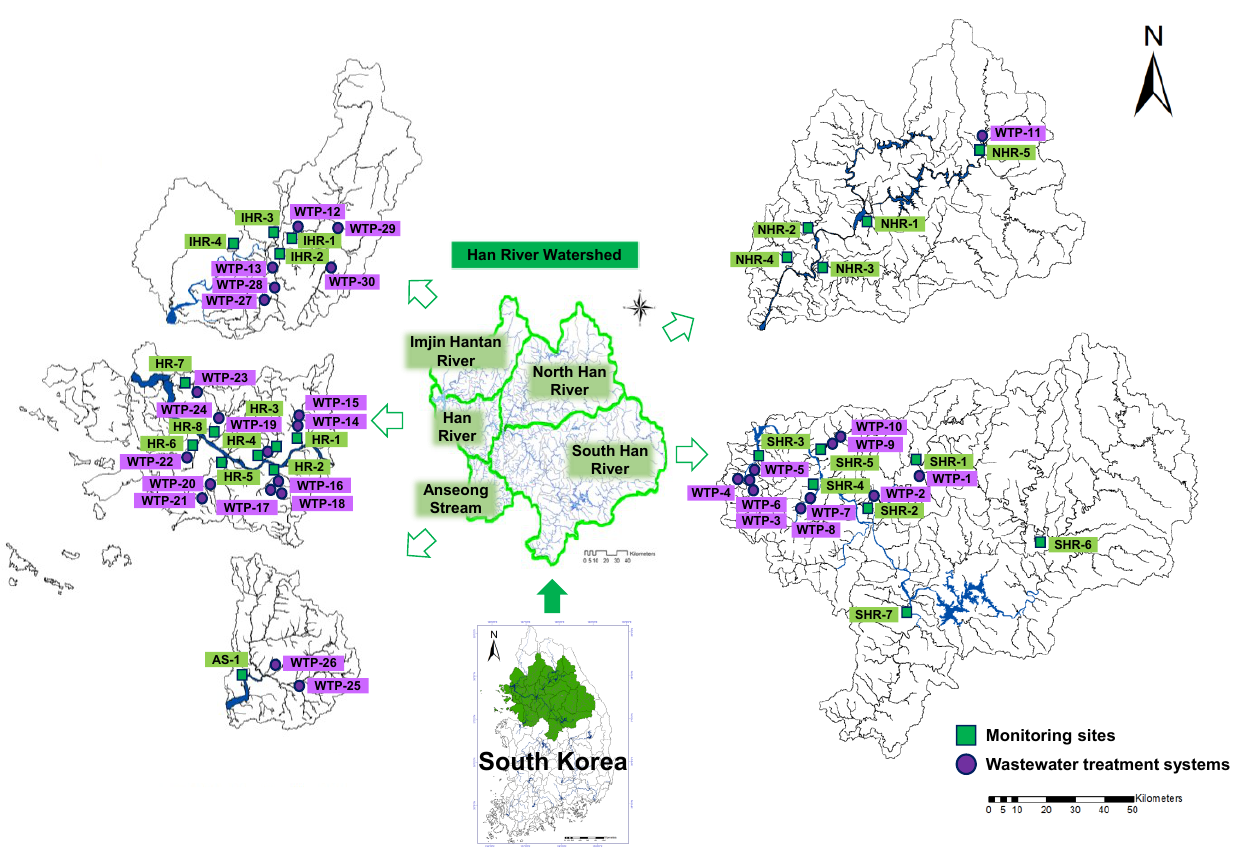
Figure 1. Han River watershed showing sampling and wastewater treatment system (WTSs) sites in five areas (HR, IHR, SHR, NHR, AS).